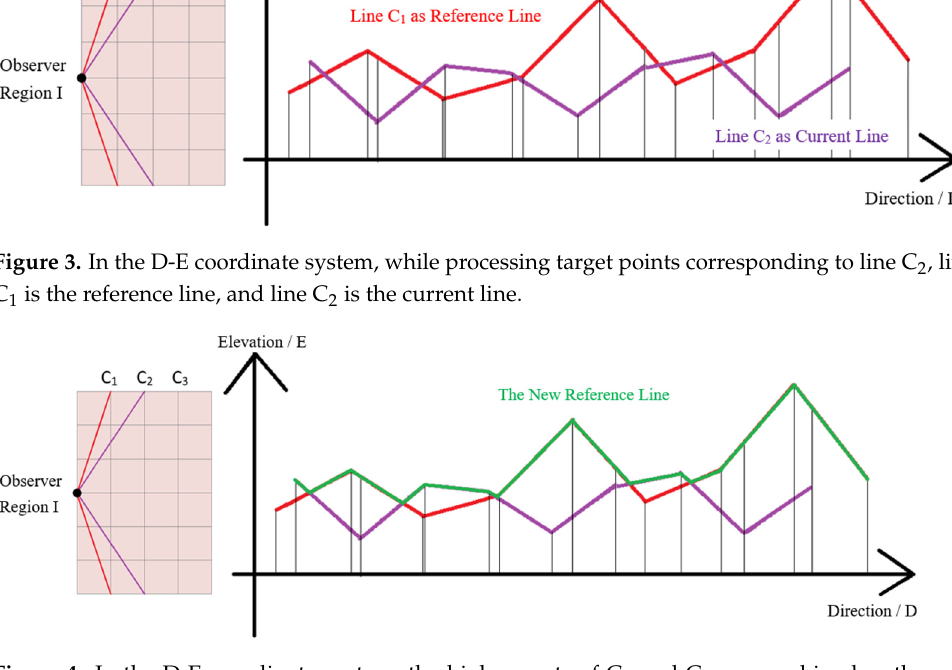
Figure 4. In the D-E coordinate system, the higher parts of C 1 and C 2 are combined as the new reference line for further computation.